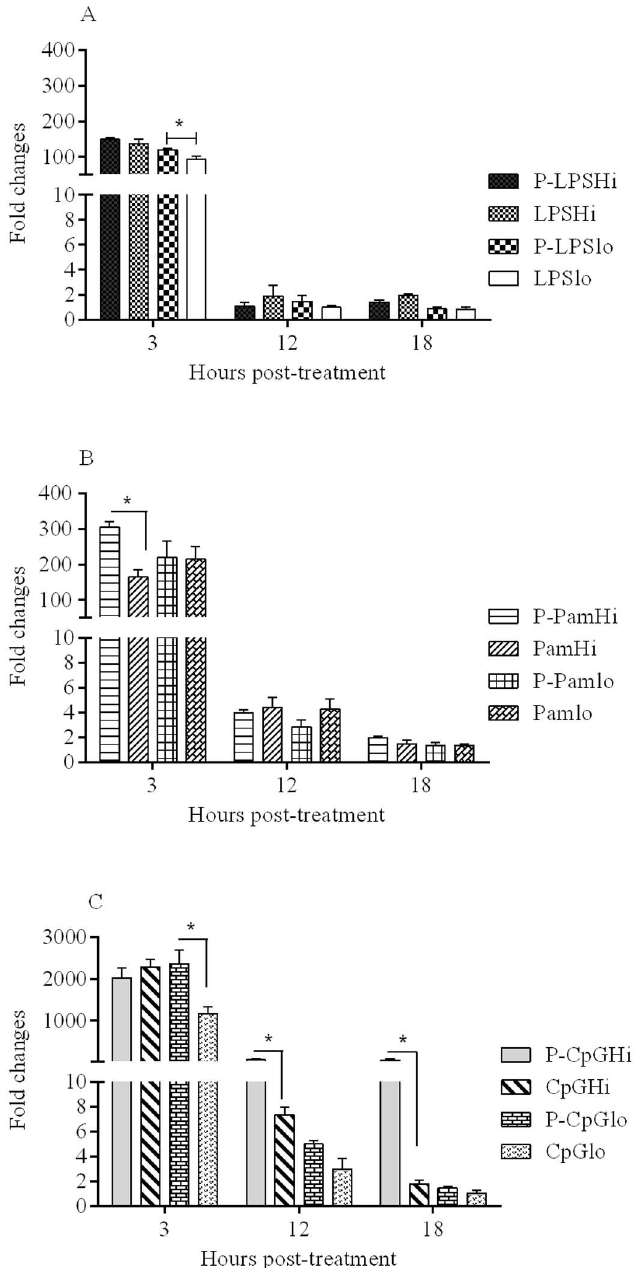
Fig 2. Expression profiles of IFN- γ for (A). LPS; (B). Pam3CSK4, and (C). CpG ODN. Chicken macrophages (six replicates/group) were treated with encapsulated and solubleforms of the three TLR ligandsand mean fold expressionof IFN- γ in treated groups were comparedto the cell culture medium treated group. Significance ( P < 0.05) was tested betweendeliverysystems (encapsulated and solubleTLR ligands) within a dose and at a given time point. *